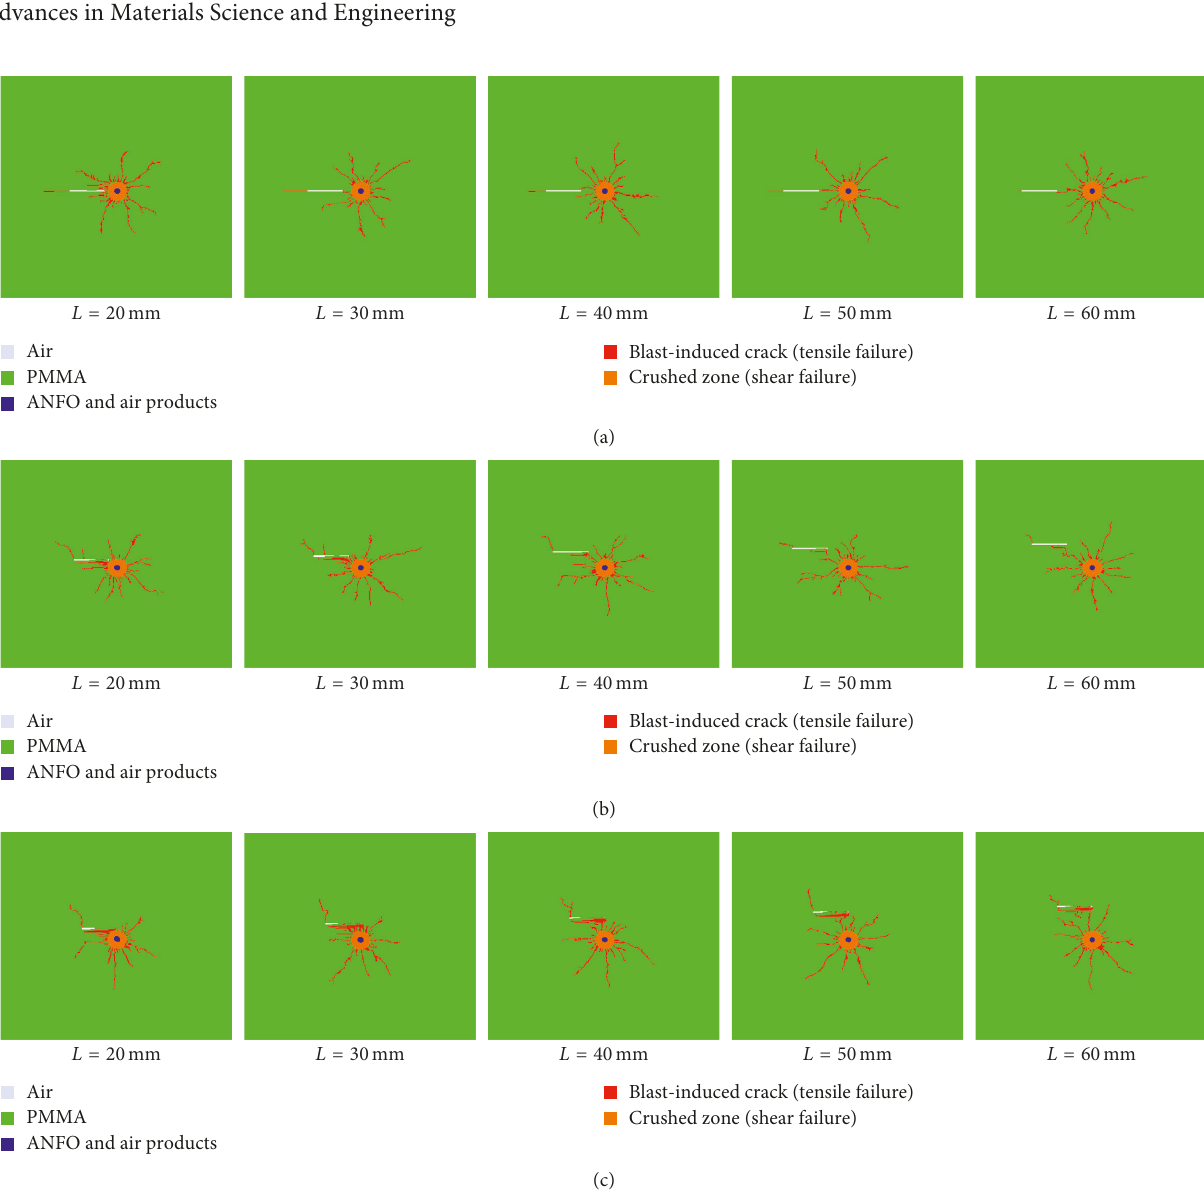
Figure 10: Material status of air-filled PMMA after explosion. (a) θ � 0 ° ; (b) θ � 45 ° ; (c) θ � 90 °